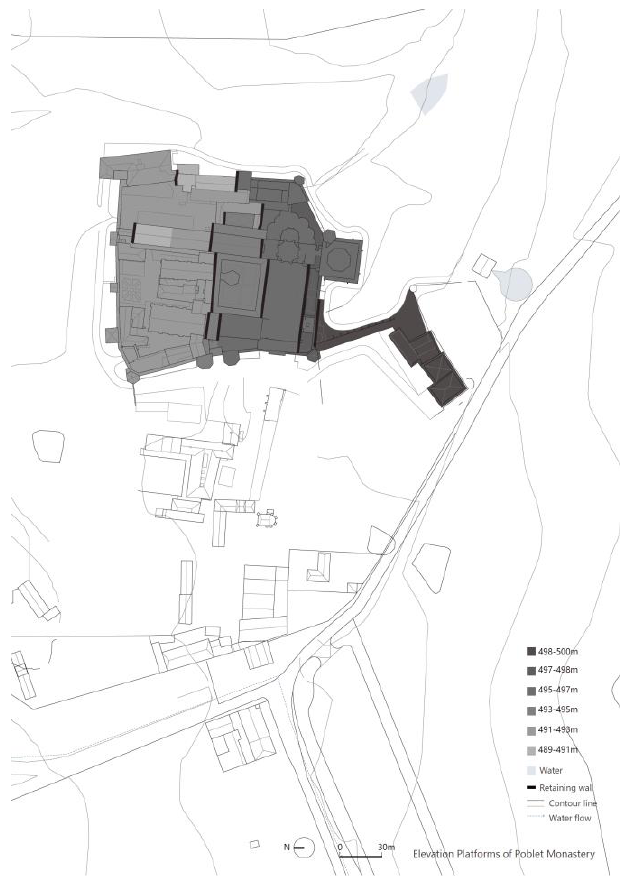
Figure 26. Elevation platforms of Poblet Monastery.